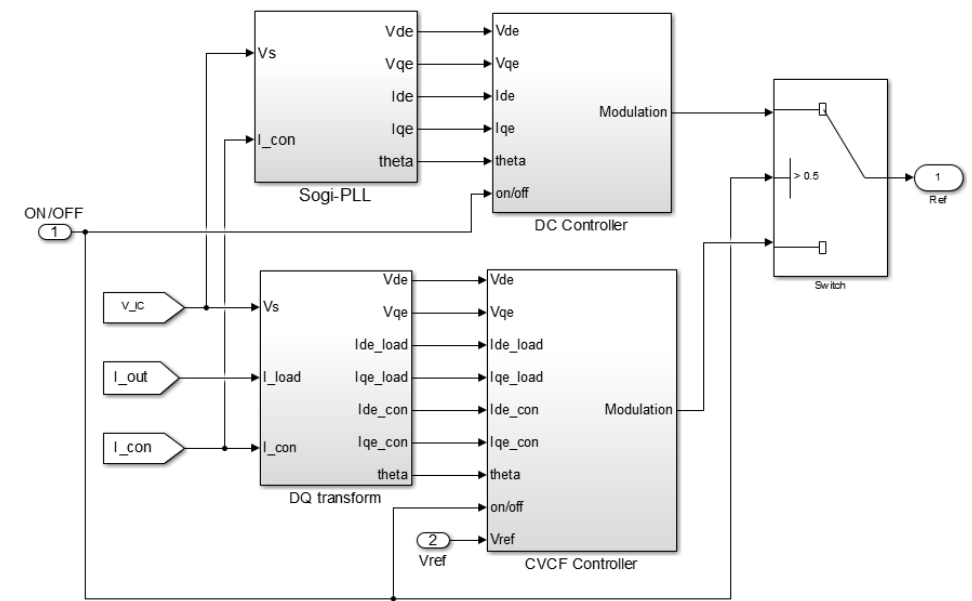
Figure A2. Control block diagram of the AC/DC interlinking converter.